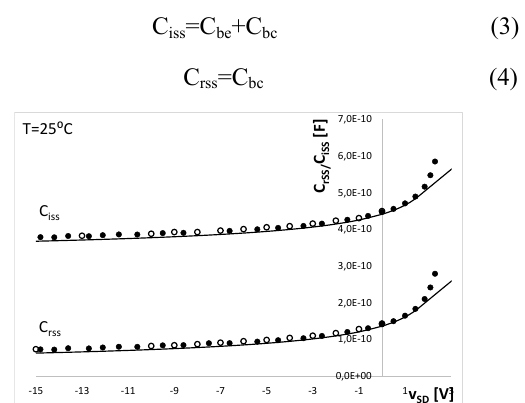
Fig.3. C iss (v SD ) and C rss (v SD ) characteristics of the 2N7635-GA transistor at the ambient temperature equal to 25 ° C.